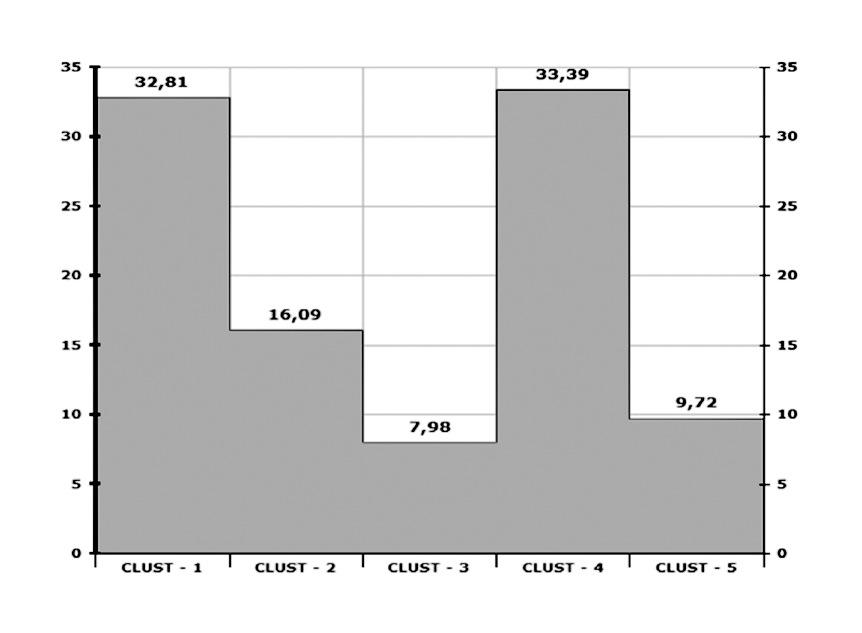
Figure 1. Histogram of